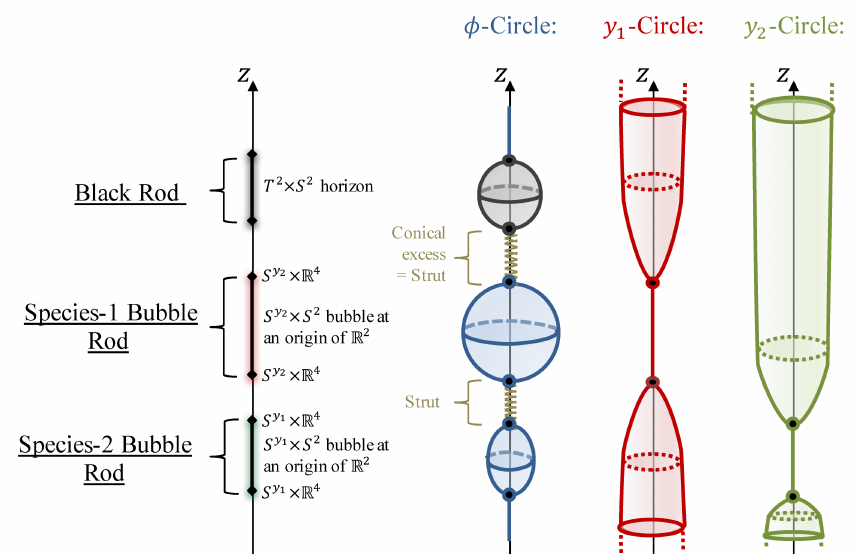
Figure 5. Schematic description of the three possible categories of physical rods and the behavior of the circles on the z -axis when the rod are disconnected. The black rod sources a two-dimensional static black brane with a T 2 × S 2 horizon. The species-1 bubble rod corresponds to the degeneracy of the y -circle inducing a S y 2 × S 2 bubble and reversely for the species-2 bubble rod. Each section 1 between sources has a conical